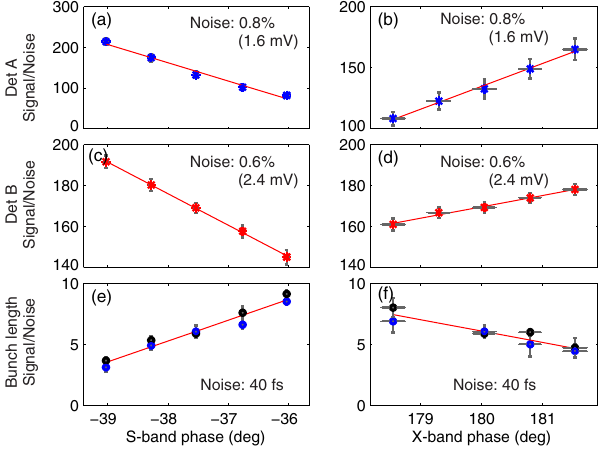
FIG. 50. Detector signals as a function of S-band and X-band rf phases controlling the bunch compression, shown for two differ- ent spectral bands: the signals of detector A, plots (a) and (b), are shown after a high-pass filter at 0.6 THz, those of detector B, plots (c) and (d), after a high-pass filter at 0.26 THz. For comparison, plots (e) and (f) show corresponding bunch-length measurements performed with the rf deflector. All signal values are displayed in relation to their corresponding noise levels as noted explicitly in the